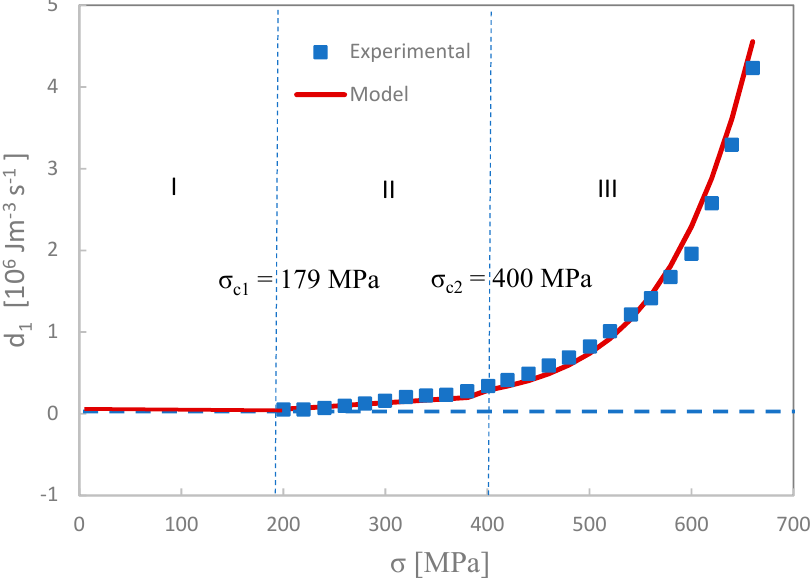
Figure 4. Stress amplitude dependence of the intrinsic dissipation of the FV520B stainless steel. Data are after [22].